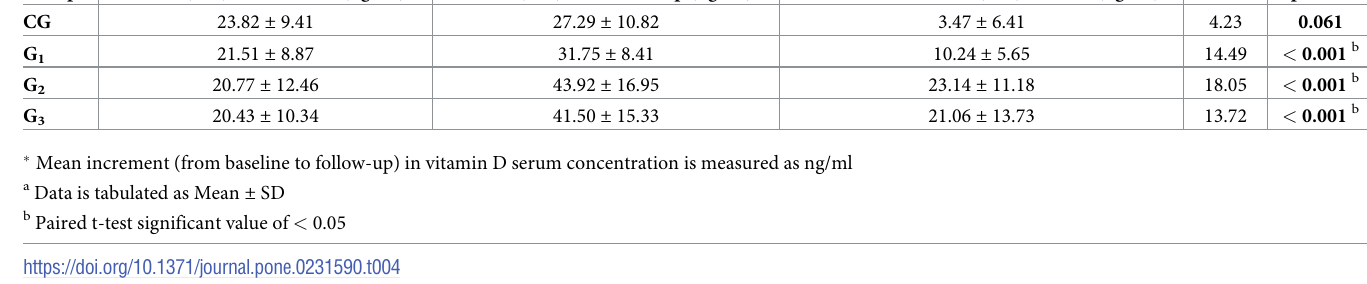
Table 4. Mean increment in the vitamin D level after supplementation (within the group analysis).